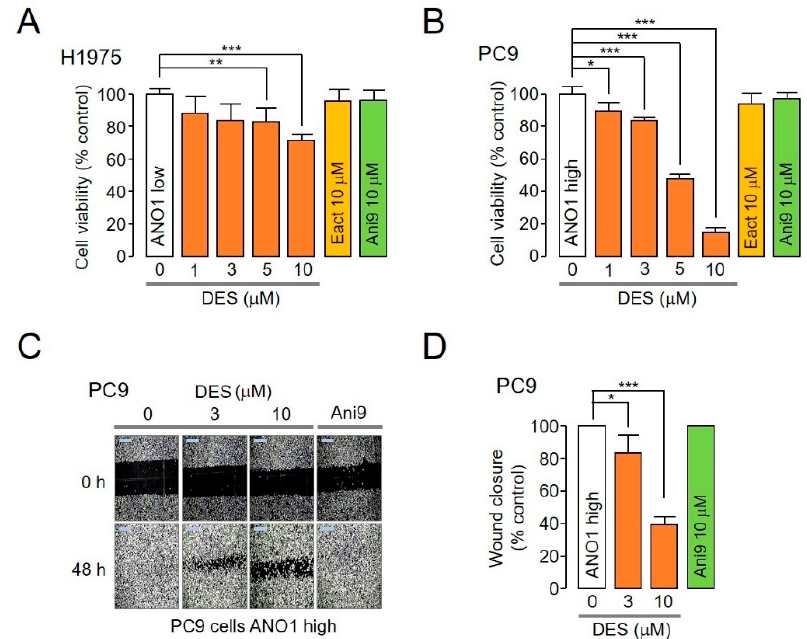
Figure 5. Effect of DES, Eact and Ani9 on cell viability and migration. ( A , B ) H1975 cells expressing low levels of ANO1 and PC9 cells expressing high levels of ANO1 were subjected to treatment with DES, Eact or Ani9 at the indicated concentrations; cell viability was determined after 72 h using the CCK-8 assay (mean ± S.D., n = 5). ( C , D ) Wound-healing assay was performed using PC9 cells expressing high levels of ANO1. The cells were subjected to treatment with 3 µ M DES, 10 µ M DES, and 10 µ M Ani9, and representative images were acquired at 0 and 48 h post wound infliction. (right) The wound closure was quantified at 48 h (mean ± S.D., n = 3). * p < 0.05, ** p < 0.01, *** p <